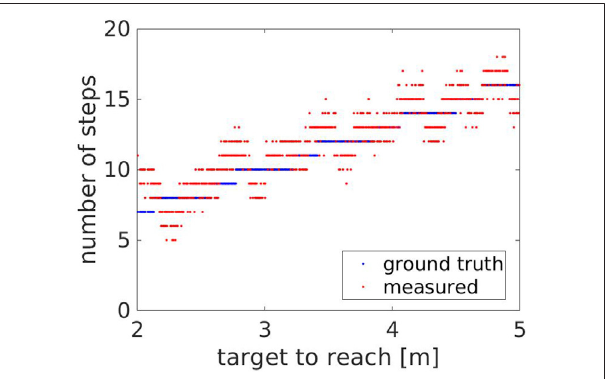
FIGURE 10 | Experiment 2: the measured (red) and the ground truth number of steps (blue) with respect to the target to reach.